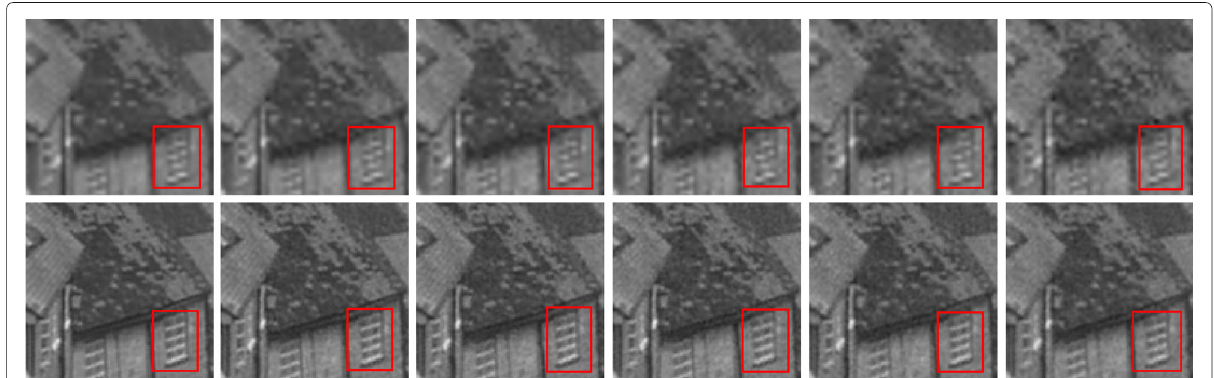
Fig. 1 Reconstructed HR images for different noise levels. Top row: one bicubic-interpolated LR image with up-sampling factor equal to 3 for each noise level, the noise variances are 0, 10, 20, 30, 40, and 50 respectively from left to right. Bottom row: corresponding final HR images reconstructed by OSR with up-sampling factor equal to 3 for each noise level